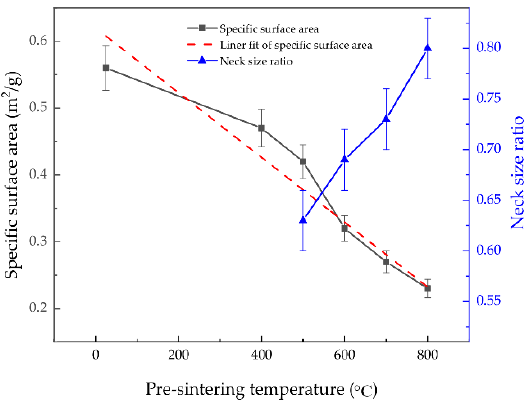
Figure 4. Specific surface area and neck size ratio versus pre-sintering temperature.